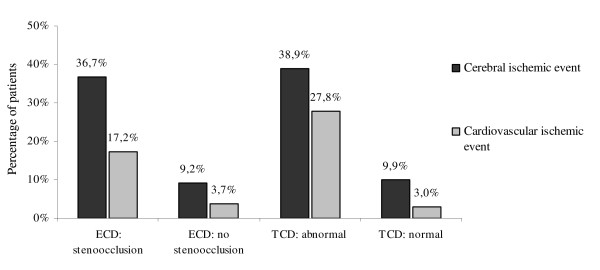
Graded risk of new vascular events based on ECD and TCD findings.